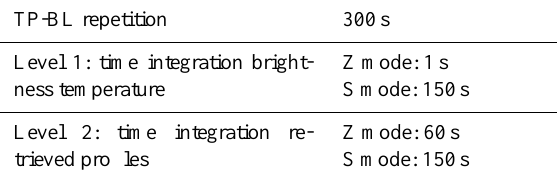
Table 4. Setup for the time repetition and time integration of our RPG-HATPRO. TP-BL repetition indicates the time between two successive scanning measurements. The measured brightness tem- perature is integrated over a certain time interval (level 1) and the retrieved profiles are then averaged (level 2).